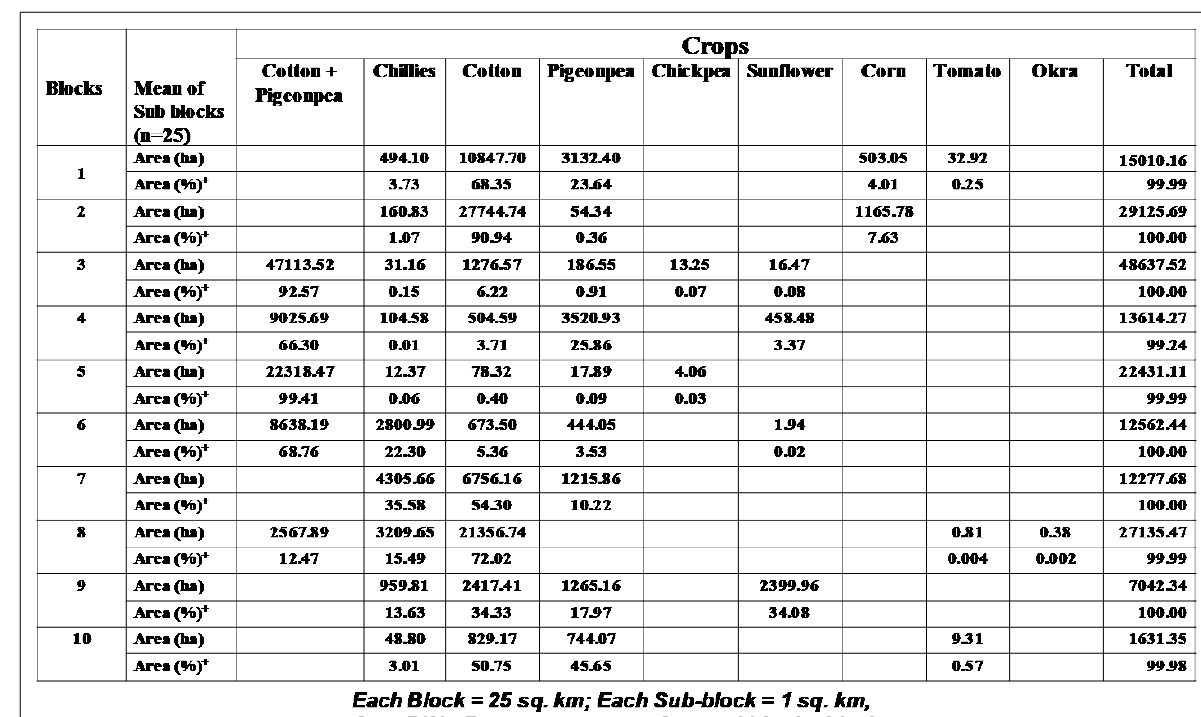
Figure-8. Change detection maps of parts of Bathinda districts (Punjab State)